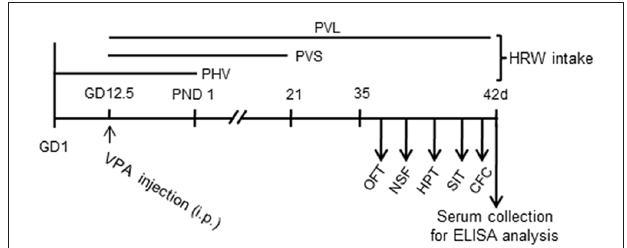
FIGURE 1 | Experiment design. Mice were injected with valproic acid (VPA) (600 mg/kg, i.p.) on pregnant day 12.5 (GD12.5) and were provided with hydrogen-rich water (HRW) during pregnant phase and after postnatal day (PND). Behavioral tests of adolescent mice offspring were conducted from PND 35 to 42. Blood samples were collected after behavioral tests for Enzyme-Linked Immune-Sorbent Assay (ELISA) assays. OFT, open field test; NSF, novelty suppressed feeding; HPT, hot plate test; SIT, social interaction test; CFC, contextual fear conditioning